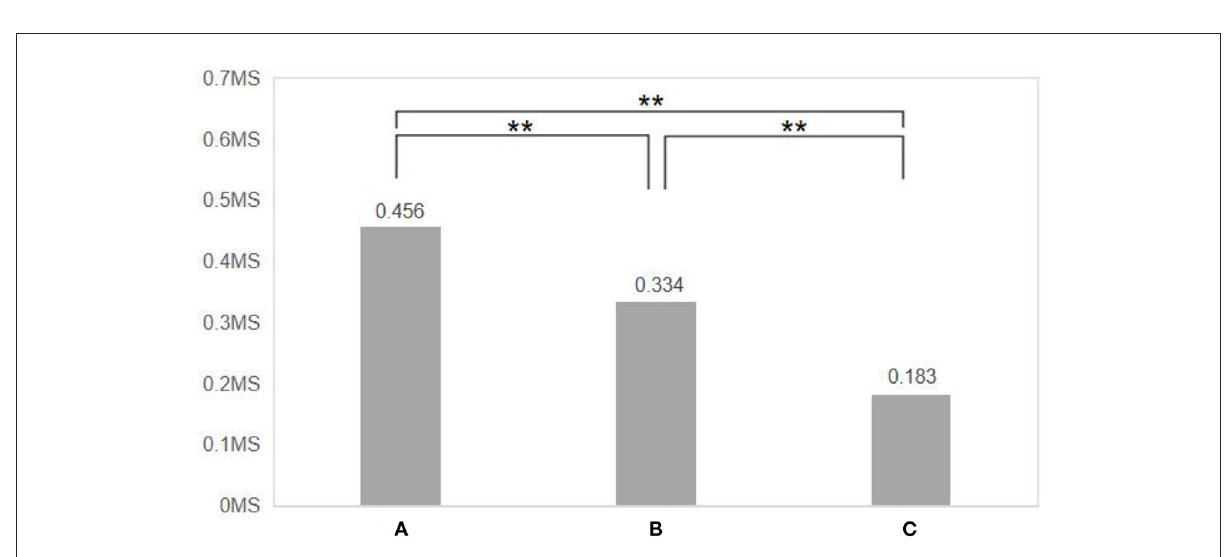
that the three virtual experimental scenarios had a promotional effect on emotional well-being in subjects of different genders. By comparing the electrodermal differences between subjects of different genders before and after experiencing the three virtual experimental scenarios (Figure 10), it was found that only in Scenario C were the data significantly different between males and females (0.197 ± 0.159 for males and 0.170 ± 0.183 for females, p = 0.047), indicating that in the scenario of a residential courtyard space with